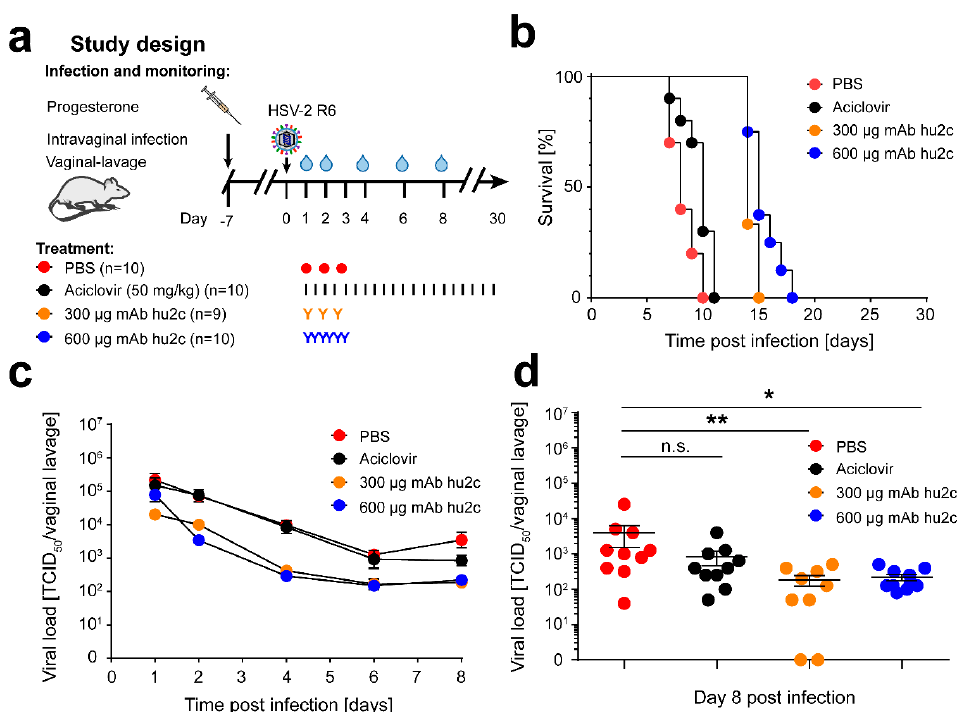
Figure 2. MAb hu2c treatment leads to a prolonged survival of HSV-2-infected NOD/SCID mice, but is not able to protect the mice from lethal HSV-2 infection. ( a ) Immunodeficient NOD/SCID mice ( n = 10 per group, except 300 µg mAb hu2c group; n = 9) were intravaginally infected with 1 × 10 6 TCID 50 /20 µL of the ACV-resistant clinical HSV-2 R6 isolate. Mice were treated with ACV (50 mg/kg; red circles) i.p. every 12 h, with mAb hu2c (300 µg, orange circles) i.v. at 24 h, 40 h, and 56 h after infection, or with mAb hu2c (600 µg, blue circles) i.v. at 24 h, 32 h, 40 h, 48 h, 56 h, and 64 h post infection. PBS administration (red circles) was used as mock treatment control and was applied i.p. every 12 h. ( b ) The figure shows survival curves of HSV-2-R6-infected NOD/SCID mice. ( c ) Virus titers of vaginal lavages were determined by endpoint dilution assay at indicated time points post infection. Data are displayed as mean ± SEM. ( d ) Virus titers of vaginal lavages were statistically evaluated using Kruskal–Wallis test and Dunn‘s multiple comparison post hoc test at day 8 post infection. Results are depicted as mean ± SEM, and significant changes are indicated by asterisks (* p < 0.05, ** p < 0.01) and non-significant changes as “n.s”.